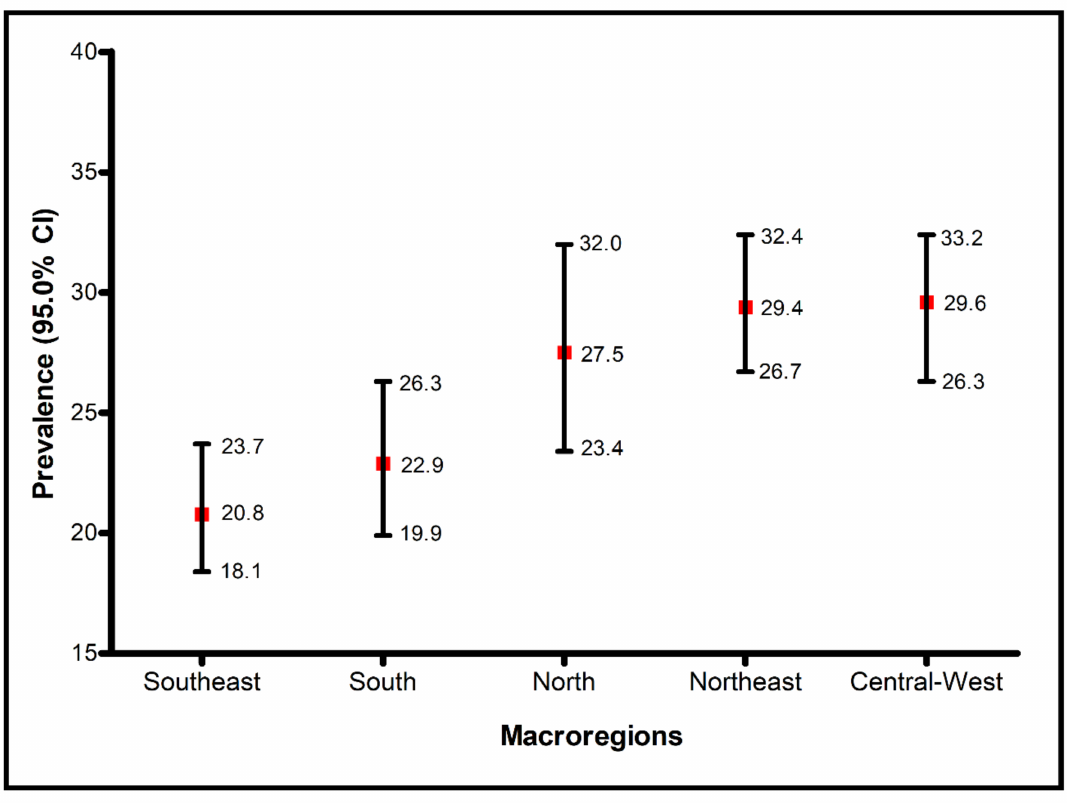
Figure 2. Prevalence of Driving Under the Influence of Alcohol in Brazil, according to macroregion. National Health Survey,